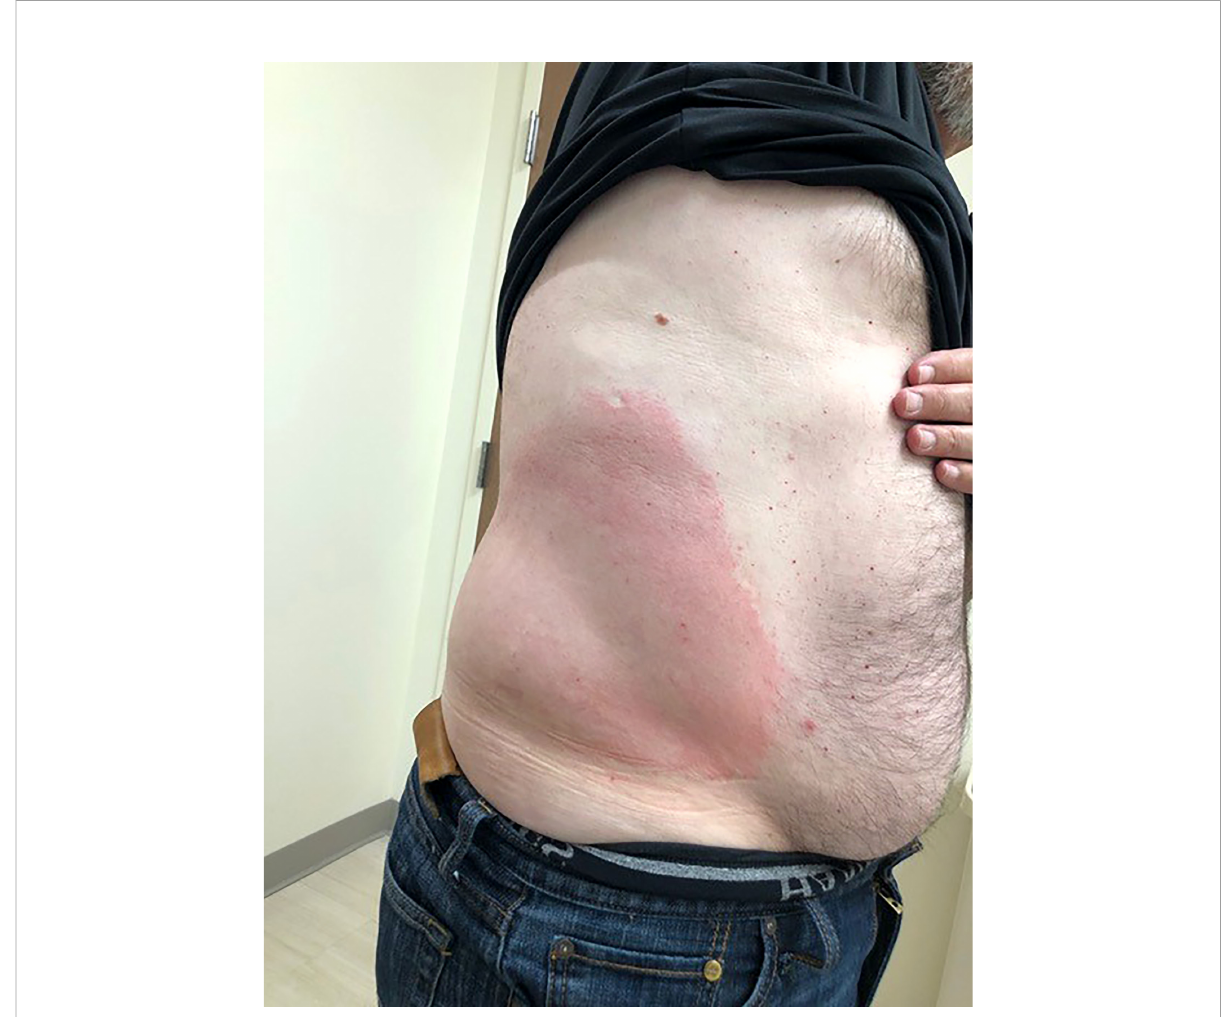
FIGURE 2 Skeeter Syndrome. The right fl ank of a middle-aged, male patient exhibiting Skeeter syndrome following a mosquito bite. This local area of redness and warmth was accompanied by fever. With previous episodes, he was given oral antibiotics from his primary care providers due to suspected cellulitis. This current episode responded well to topical corticosteroids and